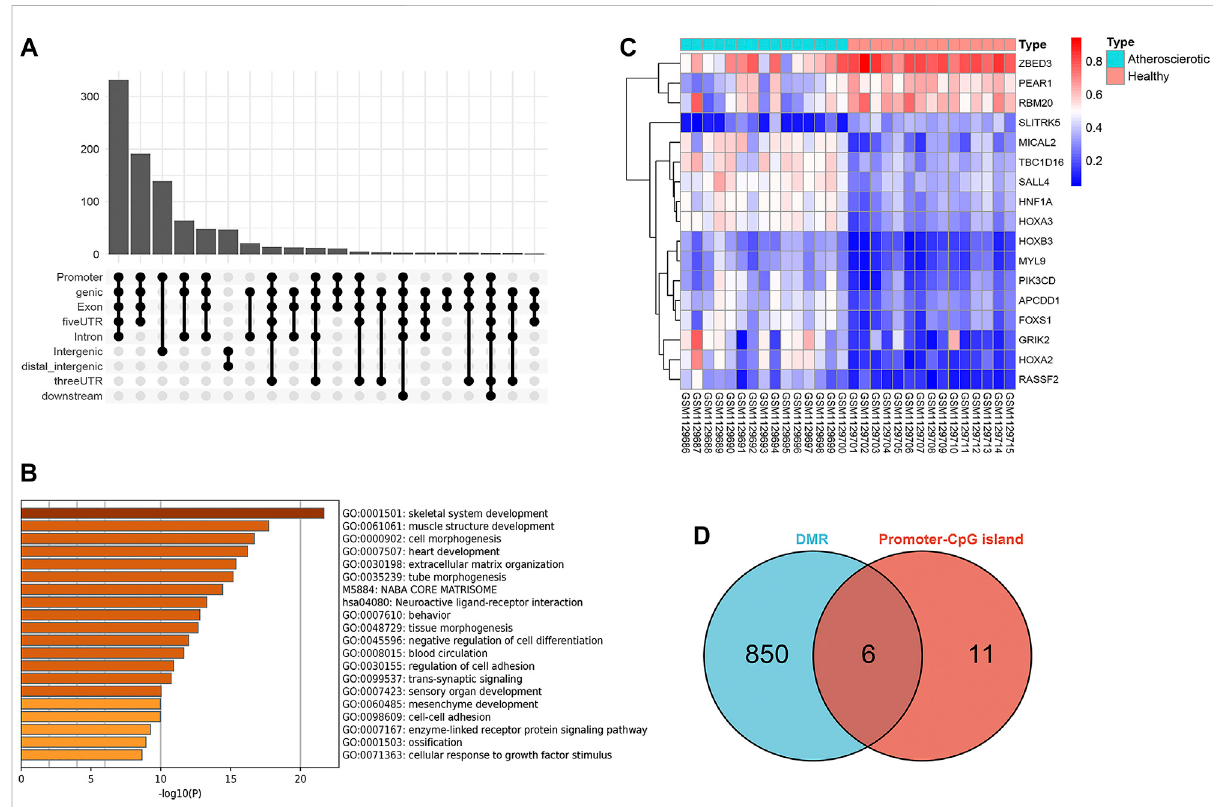
FIGURE 3 Screening of gene promoter regions enriched with differential methylation regions (DMRs). (A) Upset diagram of DMRs ’ distribution. (B) Functional enrichment analysis with Metascape. (C) Heat map of the 17 genes identi fi ed with delta β over 0.15. (D) Venn diagram identi fi ed six genes which were enriched with